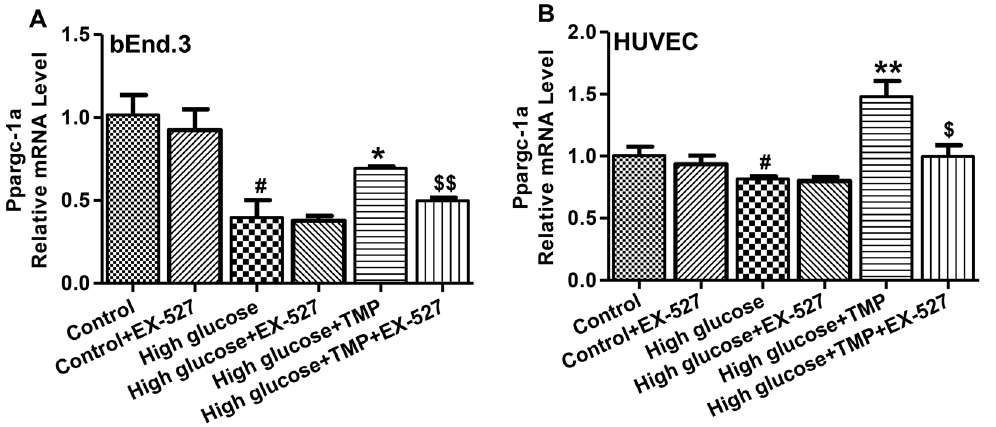
Figure 8. EX-527 abolished TMP-induced PGC-1 a up-regulation. Levels of PGC-1 a mRNA were determined by quantitative RT-PCR in the treated bEnd.3 ( A ) and HUVEC cells ( B ). Data are mean 6 SEM (n=4). # P , 0.05 vs. Control; * P , 0.05 vs. High glucose; $ P , 0.05 vs. High glucose + TMP; $$ P , 0.01 vs. High glucose + TMP.